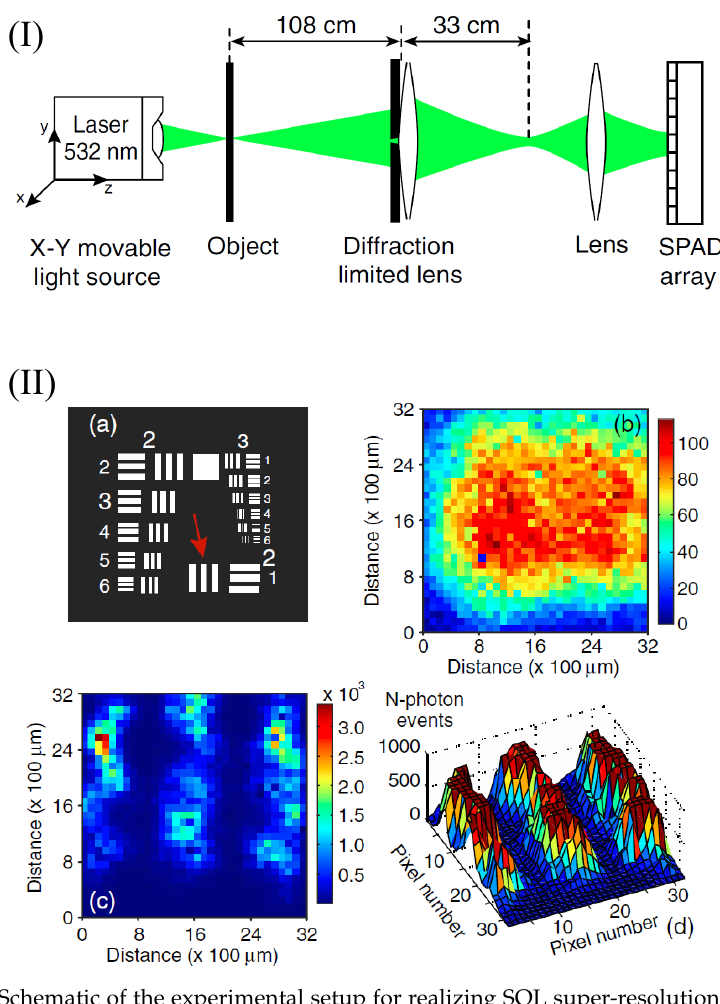
Figure 2. ( I ): Schematic of the experimental setup for realizing SQL super-resolution imaging with scanning-focused-beam illumination. ( II ): Super-resolution image realized in the experiment for a scheme with Rayleigh resolution limit 1.86 mm. The triple-slit object with slit width 125 µ m is marked by the red arrow ( a ). The intensity image realized with conventional lens-assisted imaging scheme is presented in ( b ), and the super-resolution image realized with the n-photon detection ( n = 23) is shown in ( c ) and ( d ), where ( d ) is the three-dimensional image of ( c ) by clipping the event counts at 800. The figure is reproduced with permissions from Ref. [32] of